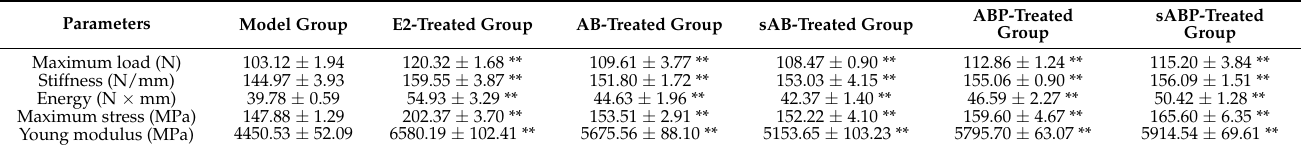
Table 3. Bone biomechanical indexes of the femoral diaphysis of rats in different groups. Parameters Model Group Values are mean ± S.E.M. ** p < 0.05 vs. model group as evaluated by